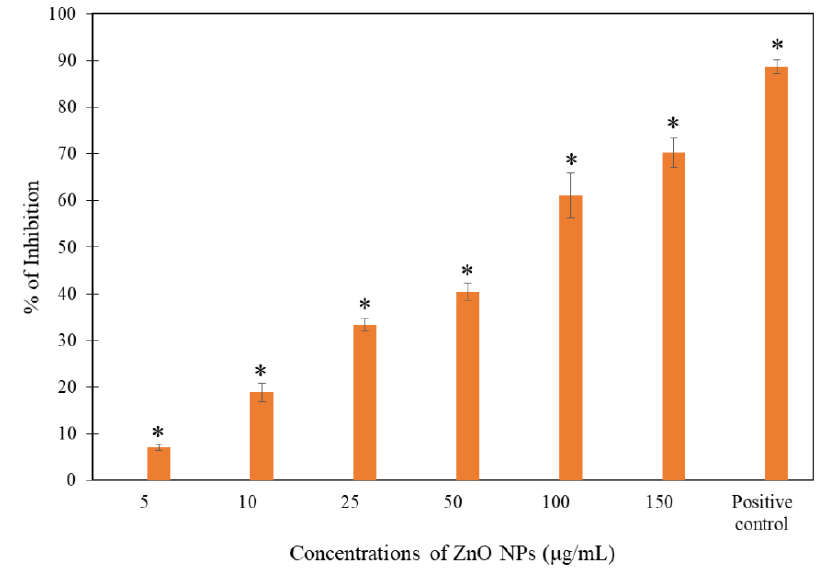
Figure 4. The percentage of growth inhibition on S. cerevisiae after treatment with six distinct concentrations of ZnO NPs for 24 h at 25 °C in SDB. The values plotted in the graph are in mean ± standard deviation. * Demonstrates the significant difference between control and yeast suspension treated with ZnO NPs at p < 0.05.